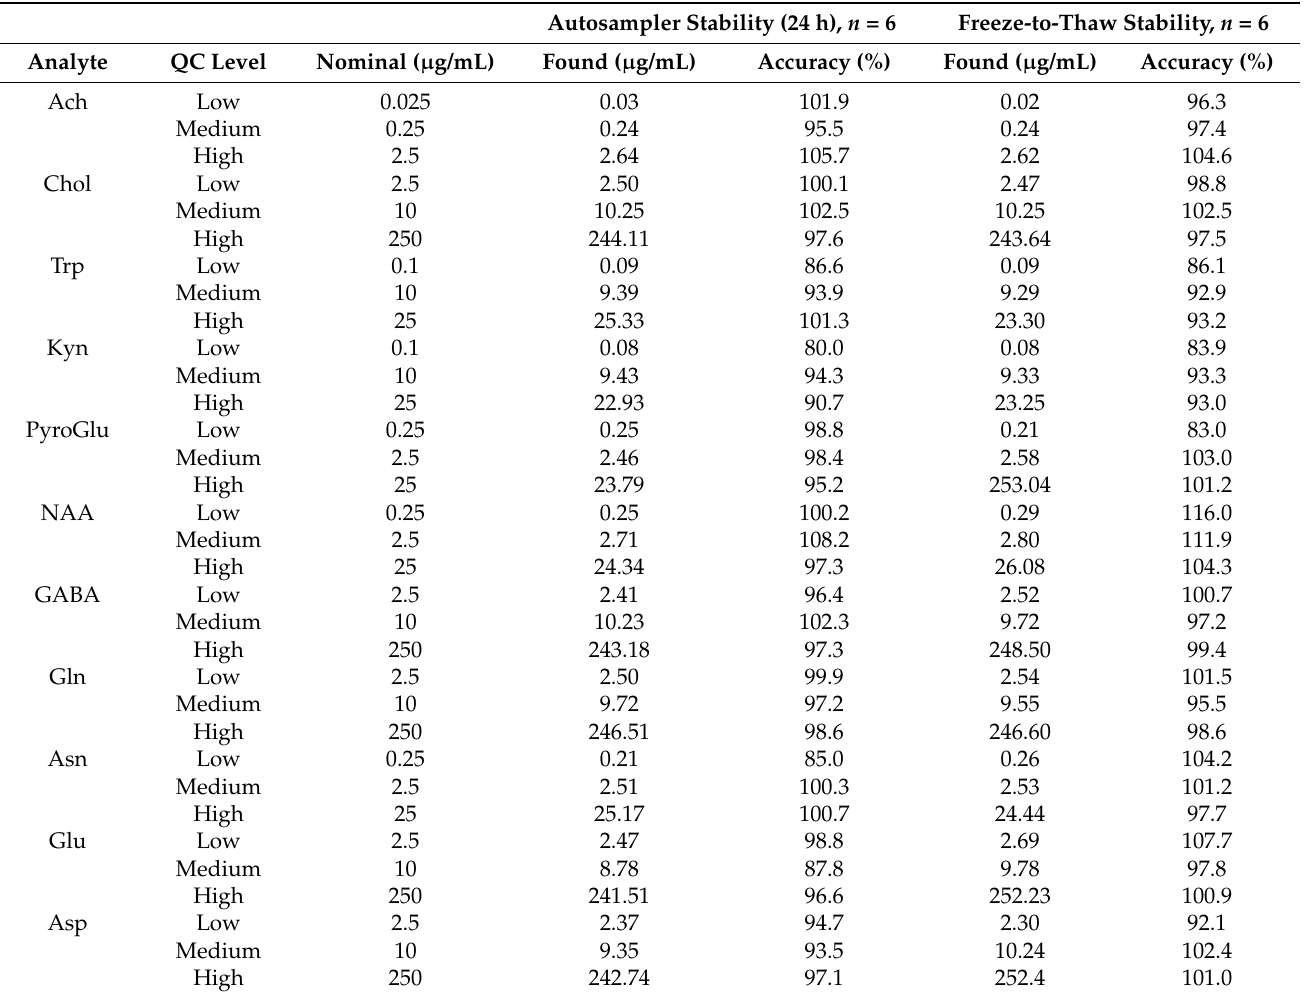
Table 4. Stability testing of the NT, tryptophan and